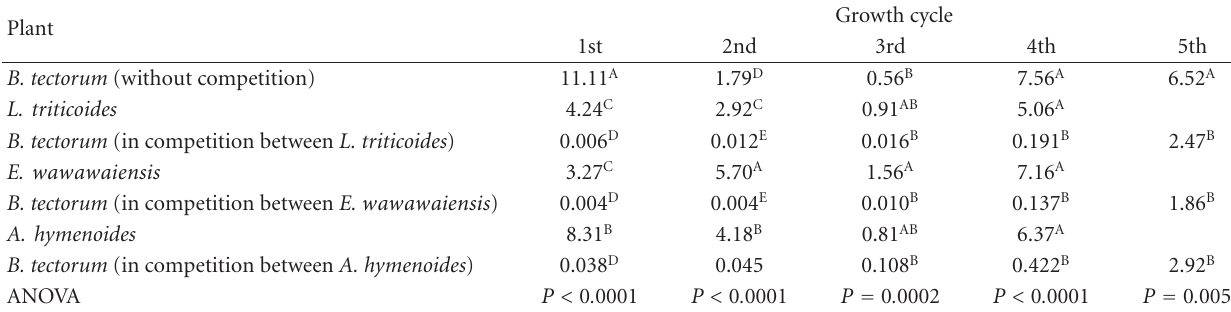
Figure 1: (a) was taken in the Virginia Range of northern Nevada, USA. These high elevation communities are dominated by the low sagebrush species Artemisia arbuscula due to the clay-textured soils. The trees are Juniperus occidentalis that are greatly expanding their range. The grass in the foreground is the native perennial bunchgrass Psuedoreogneria spicata , which e ff ectively suppresses growth of Bromus tectorum . The vegetation in the background is dominated by B. tectorum , which we suspect is due to loss of P. spicata . (b) shows a rhizotron used in the greenhouse experiment with the back removed to observe rooting patterns. Photograph was taken near the completion of the 3rd growth cycle (addition of activated carbon) and shows the perennial grass A. hymenoides with a small plant of B. tectorum between. Table 3: Mean above-ground biomass (g) by plant species and growth cycle.